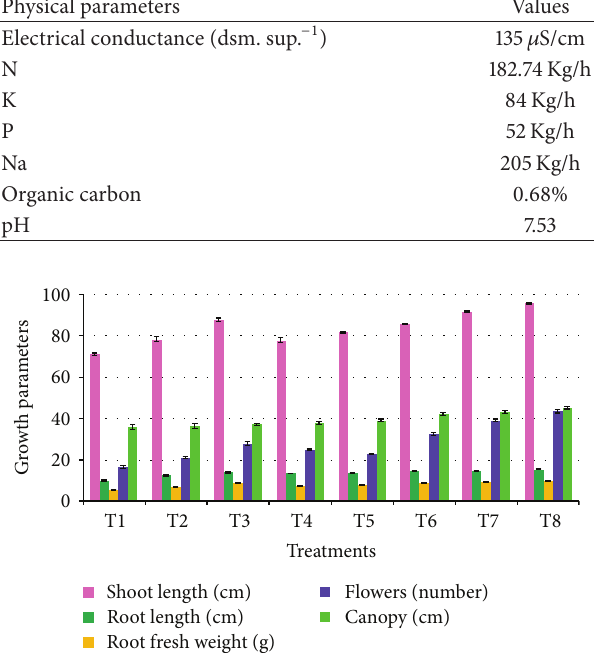
Figure 1: Growth parameters as influenced by the microbial treatments in Ocimum tenuiflorum cv. CIM-Ayu. a. Standard error of means (SEM) is indicated by the error bars.